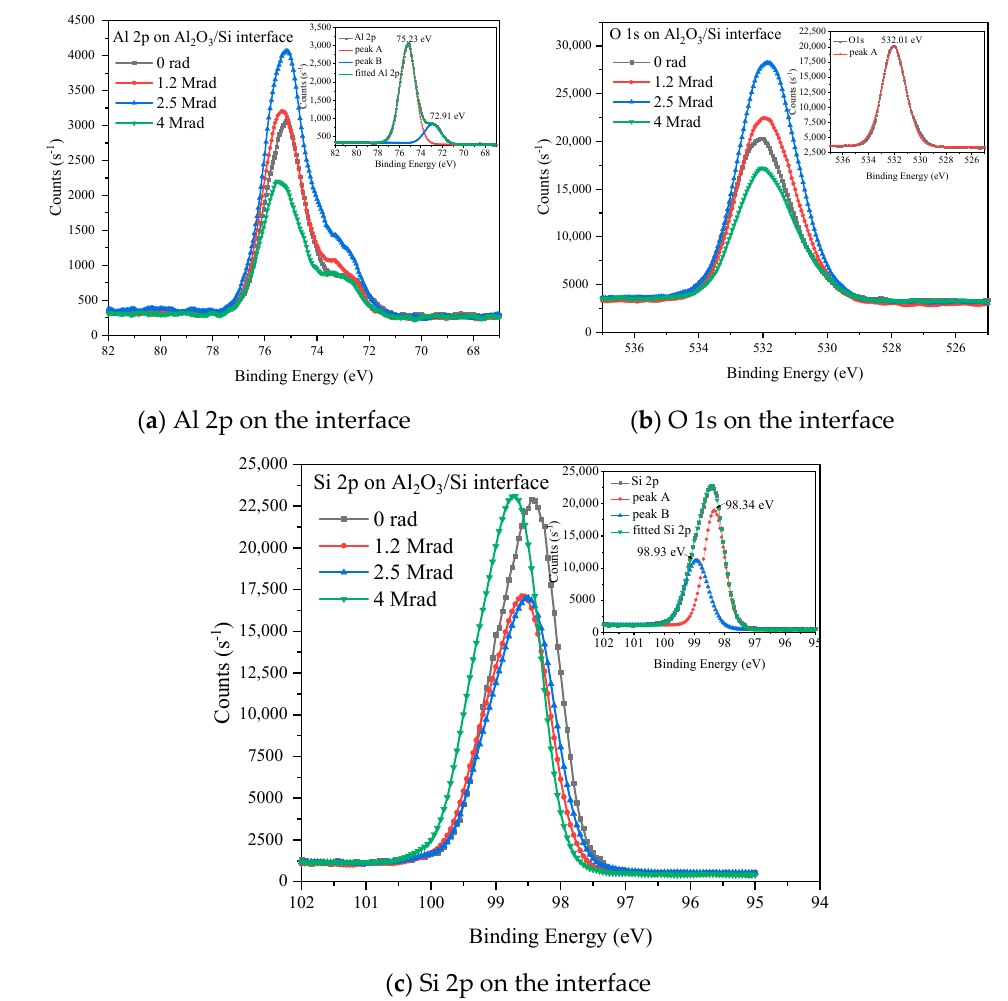
Figure 4. Detailed XPS results taken on Al 2 O 3 /Si interface.